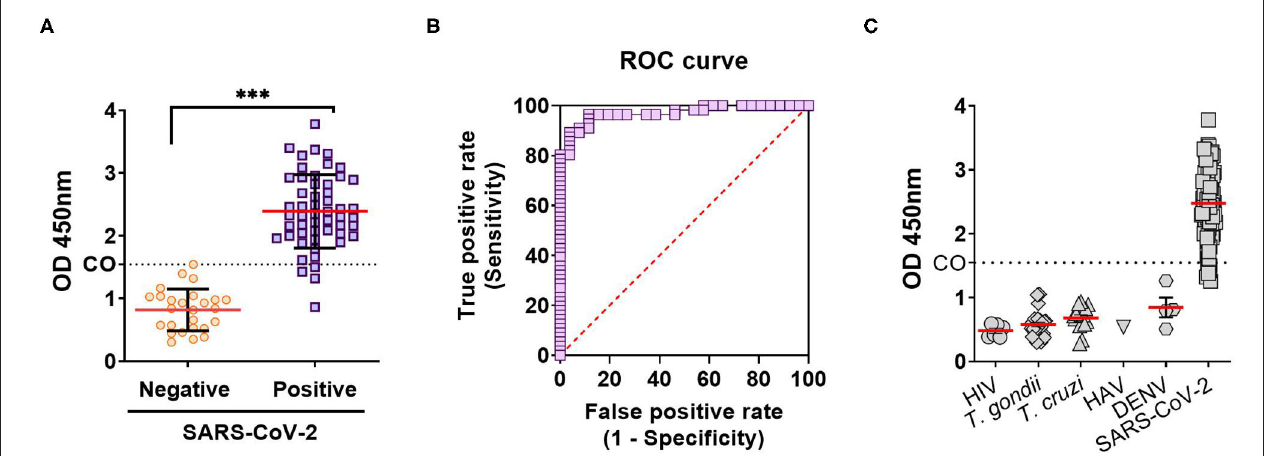
FIGURE 1 | Diagnostic performance of an anti-RBD “ In-House ” ELISA for SARS-CoV-2. (A) Anti-RBD IgG antibodies on true negative (pre-pandemic sera, taken before December 2019) and true positive (by RT-PCR and CMIA anti-N IgG antigen test) samples for SARS-CoV-2 infection. Results are expressed as the OD 450nm, and the cutoff (CO) calculated using the ROC curve (*** p < 0.0001). (B) Diagnostic efficacy of the RBD antigens in SARS-CoV-2 infection calculated from ROC curve. (C) IgG antibodies against RBD in sera from individuals with infections by: HIV, human immunodeficiency virus; T. gondii , Toxoplasma gondii ; T. cruzi , Trypanosoma cruzi ; HAV, human hepatitis A virus; and DENV, Dengue virus.